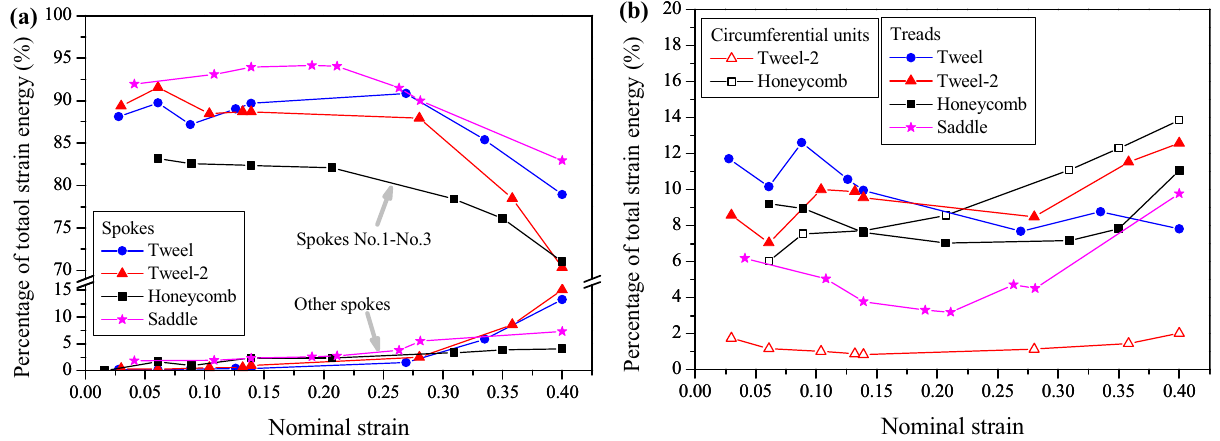
Figure 8: Percentage of the stored strain energy relative to the total strain energy under quasi - static uniaxial compression for ( a ) spokes, divided into two groups: spokes 1 – 3 and the rest; ( b ) circumferential units and treads of tire